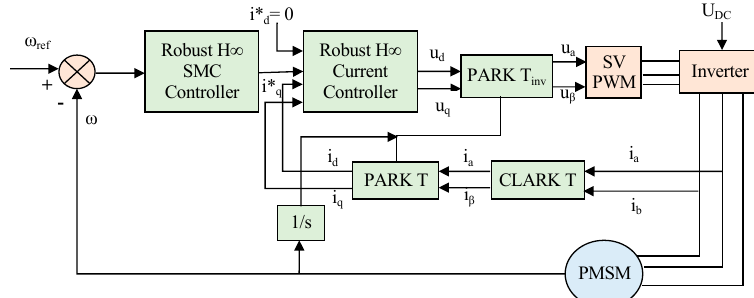
Figure 1. Principal diagram of PMSM speed regulation based on H ∞ robust controller.